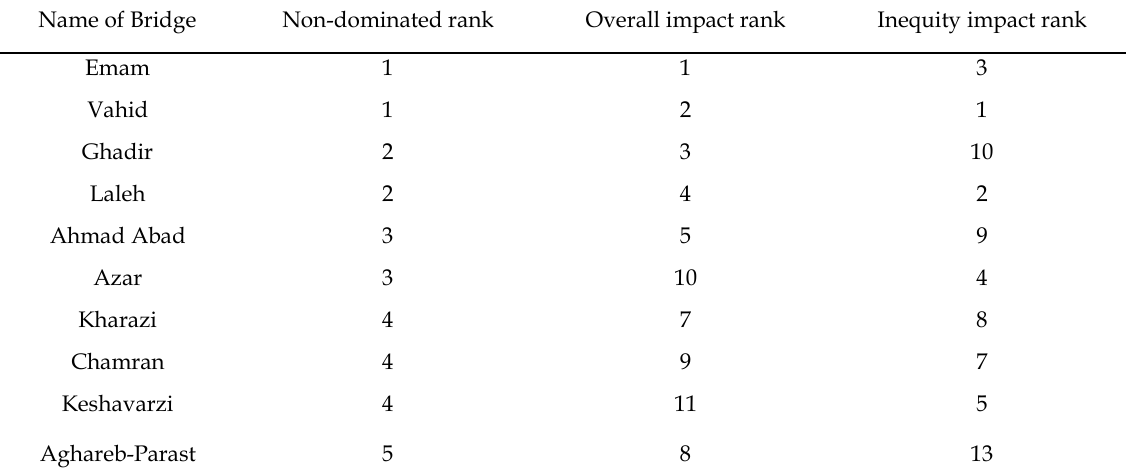
The final most critical bridges